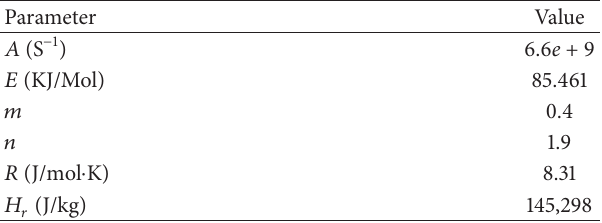
Figure 3: Comparison of the degree of cure between measurement and cure kinetics model. Table 1: Constant of cure kinetics for silicone.